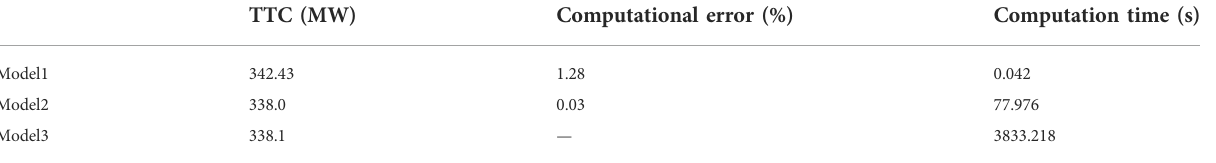
TABLE 7 Computational comparison for different computational